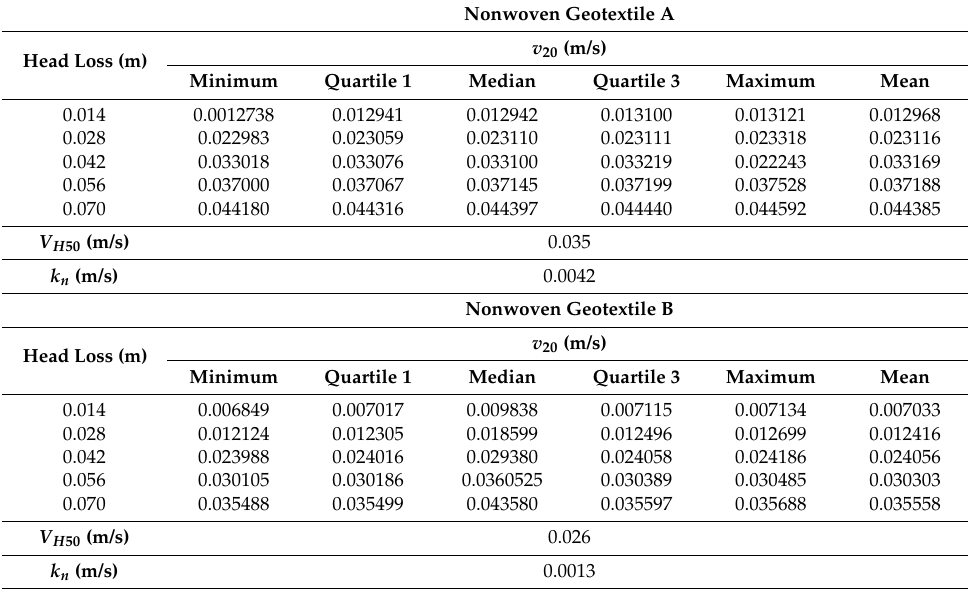
Table 2. Summary of statistical analyses of hydraulic properties for the tested nonwoven geotextiles.